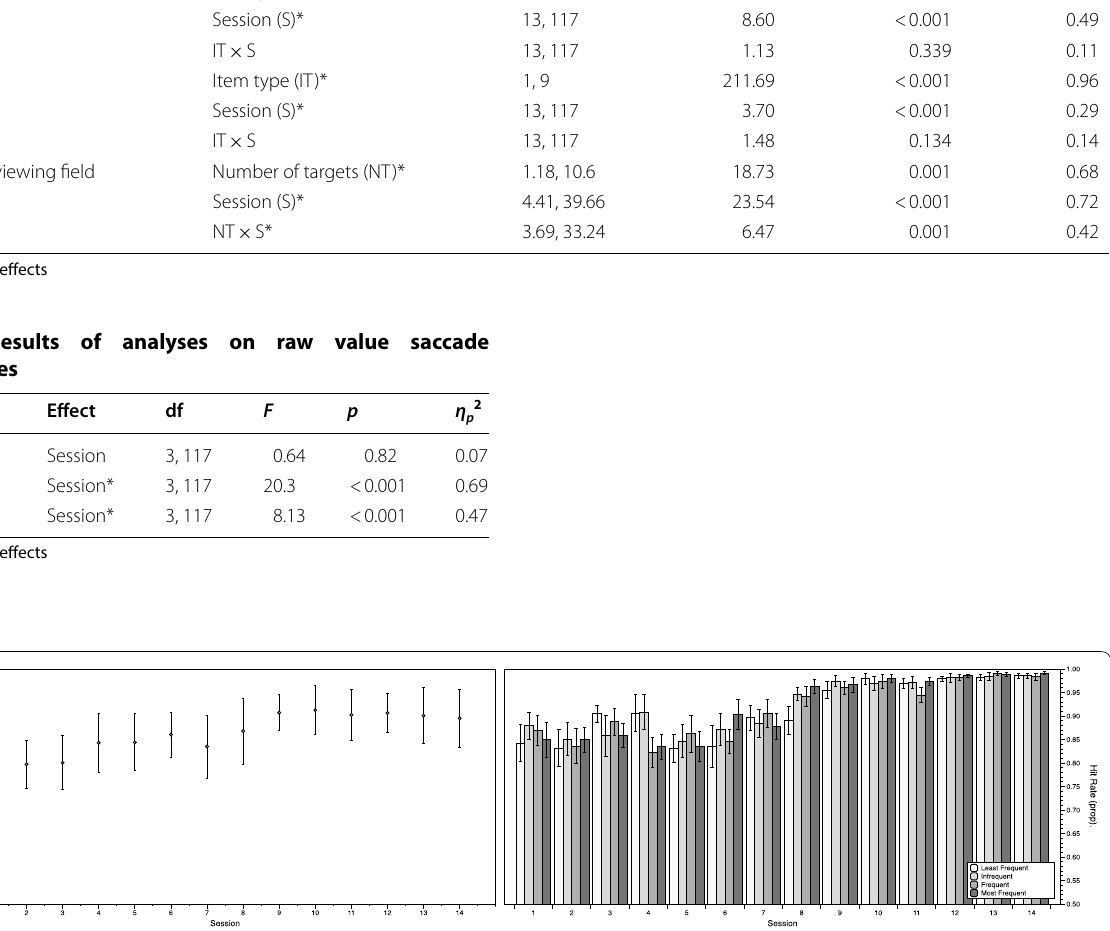
Fig. 14 Total points accumulated across sessions (left panel) and hit rates across sessions as a function of target frequency (right). Error bars are standard error